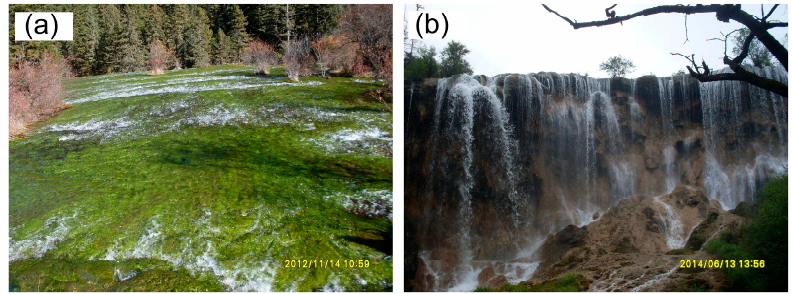
Figure 2. The changes of water and tufa landscape in Jiuzhaigou showing: ( a ) Algae growing; ( b ) Tufa landscape collapse.